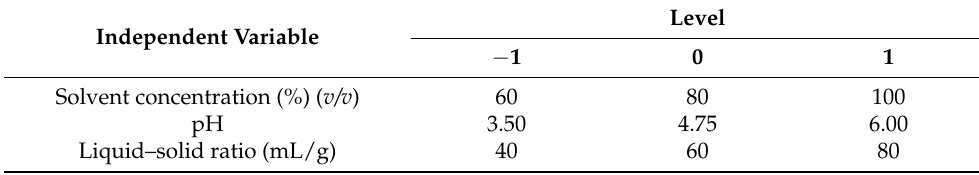
Table 4. Levels of the independent variables considered in the Box–Behnken